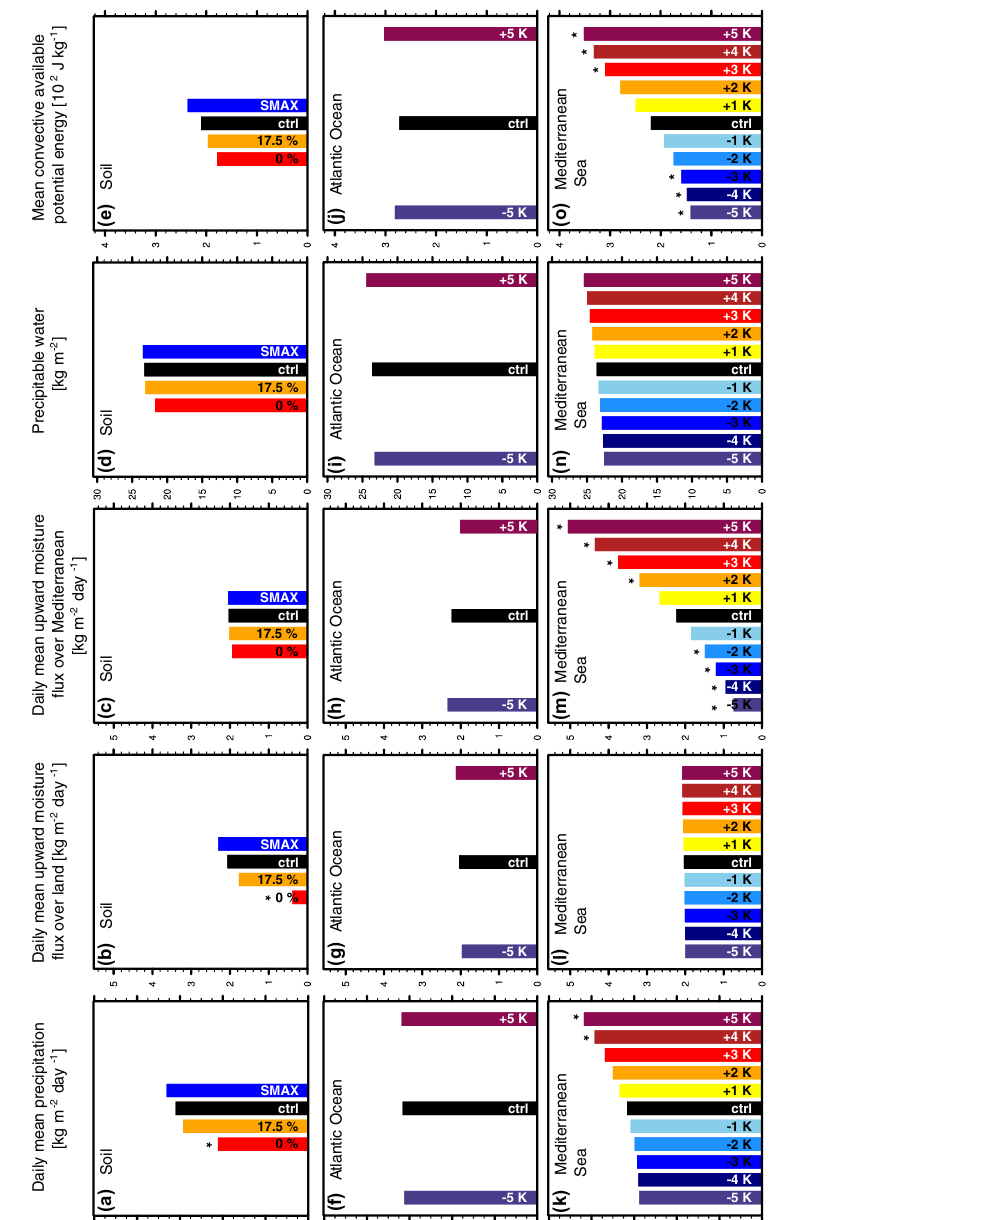
Figure 4. The panels in the first row show the mean over 5 Vb events for the soil experiments with a bar for drainage (0%, red), southern Spanish soil water conditions (17.5%, orange), the control simulation (ctrl, black), and full saturation (SMAX, blue). The second row shows the mean over 5Vb events for the Atlantic SST experiments, with bars depicting a decrease in SSTs of 5K on the left (blue), the control simulation in the middle, and an increase in SSTs of 5K on the right (red). The third row shows the mean over 5Vb events for the Mediterranean SST experiments, with bars depicting a decrease in SSTs of 5K on the left and an increase in SSTs of 5K on the right, with increments of 1K. The five columns show the daily mean precipitation, upward moisture flux over land and over the ocean, and mean convective available potential energy (CAPE) for D3 from the left to the right. Stars above the bars denote significant changes compared to the control simulation using a non-parametric Mann–Whitney U test and the 5% significance level. The units for the y axis are given in the header of each column, whereas the x axis denotes the performed sensitivity